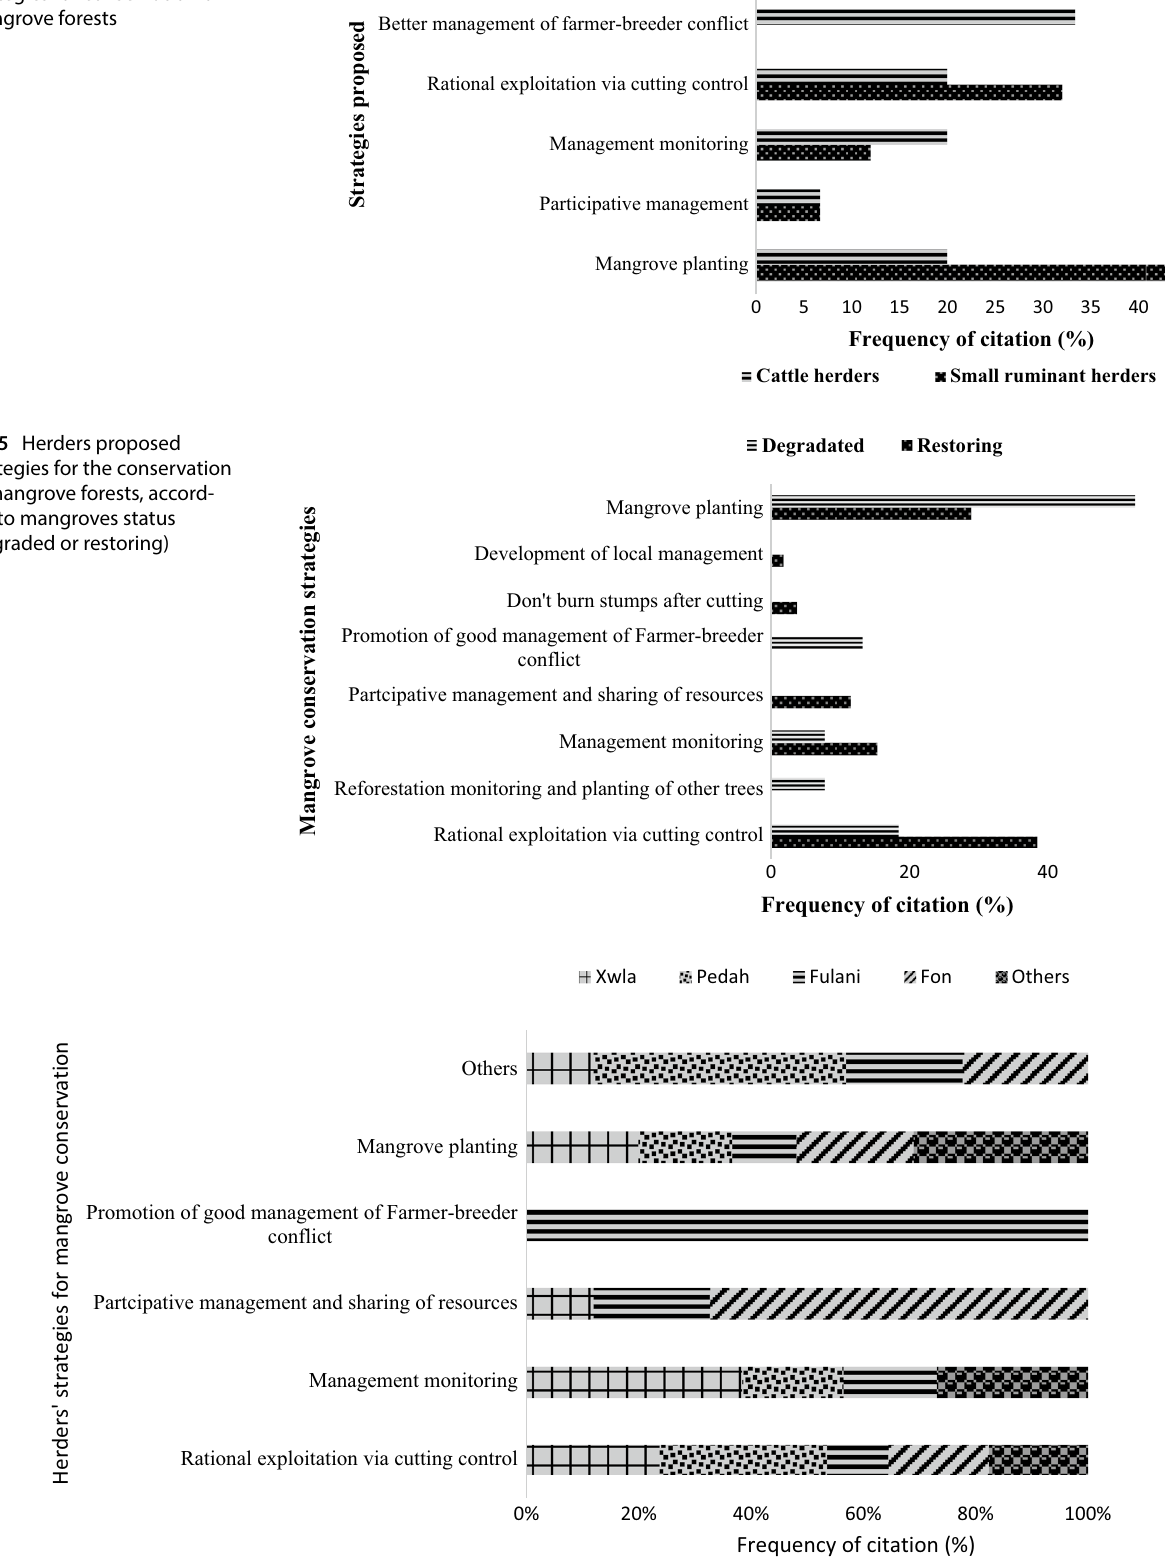
Fig. 4 Cattle and small ruminant herder’s proposed strategies for conservation of mangrove forests